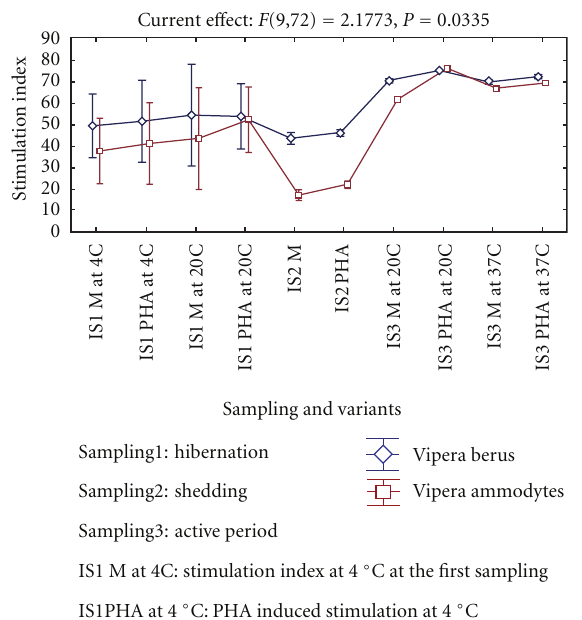
Figure 3: Environmental temperature induced in vitro changes in blast transformation indices of leukocyte cultures in common and nose-horned vipers.